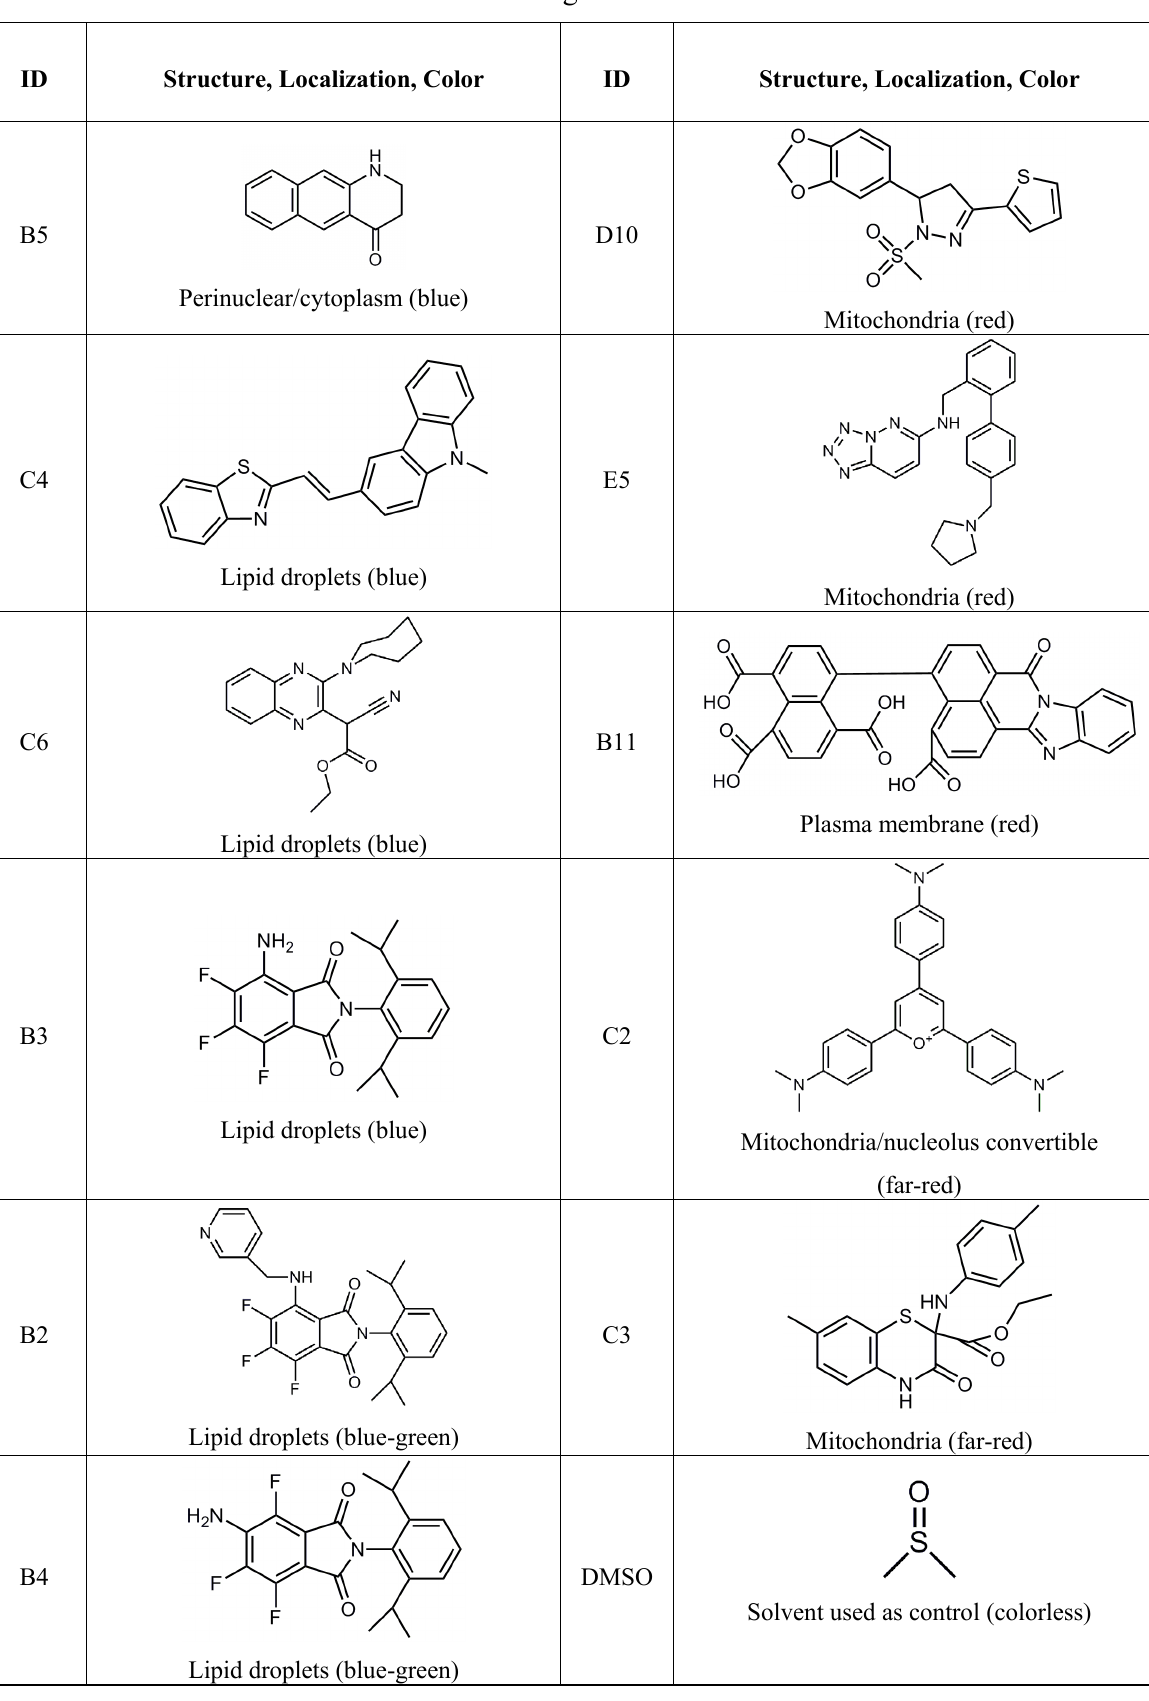
Table 1. Chemical structures and labeling characteristics of the selected